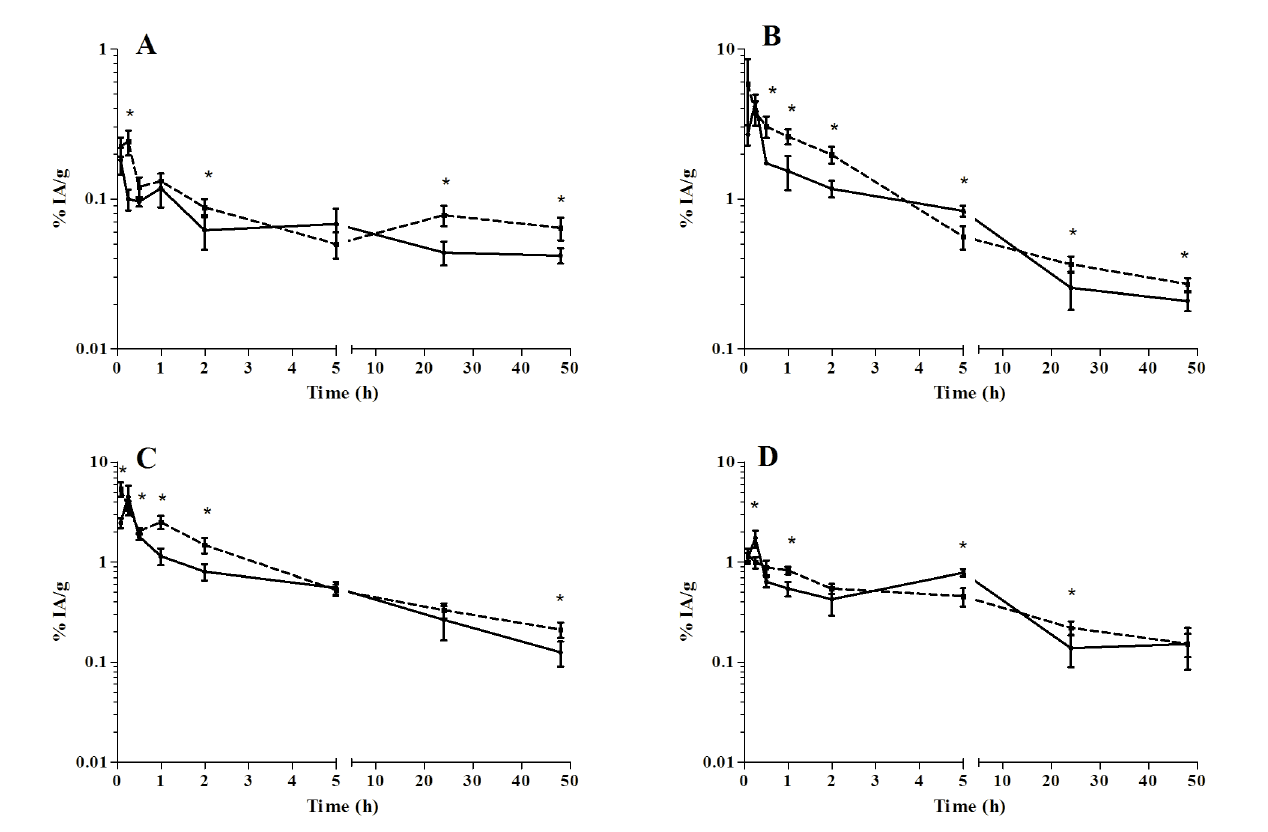
Figure 1 Antimony biodistribution in uninfected [22] and L. ( L. ) amazonensis -infected BALB/c mice after intraperitoneal administration of meglumine antimoniate. A : brain; B : heart; C : lung; D : muscle. Continuous line: infected mice; dotted line: uninfected mice. Data are expressed as the mean ± standard deviation (n= 5/time) of the percentage of injected activity (IA) per gram. The significance of differences between uninfected and infected mice was calculated by Student’s t test. * p < 0.05.